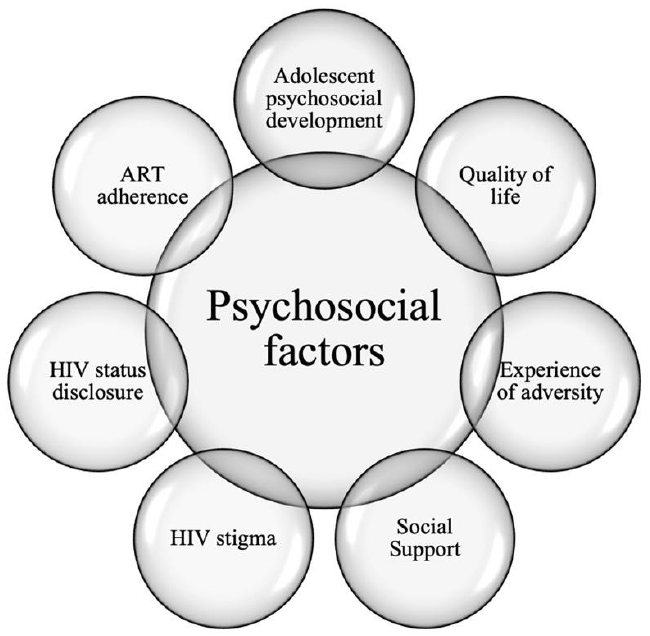
Figure 2. Psychosocial factors which affect ALHIV accessing HIV treatment services.